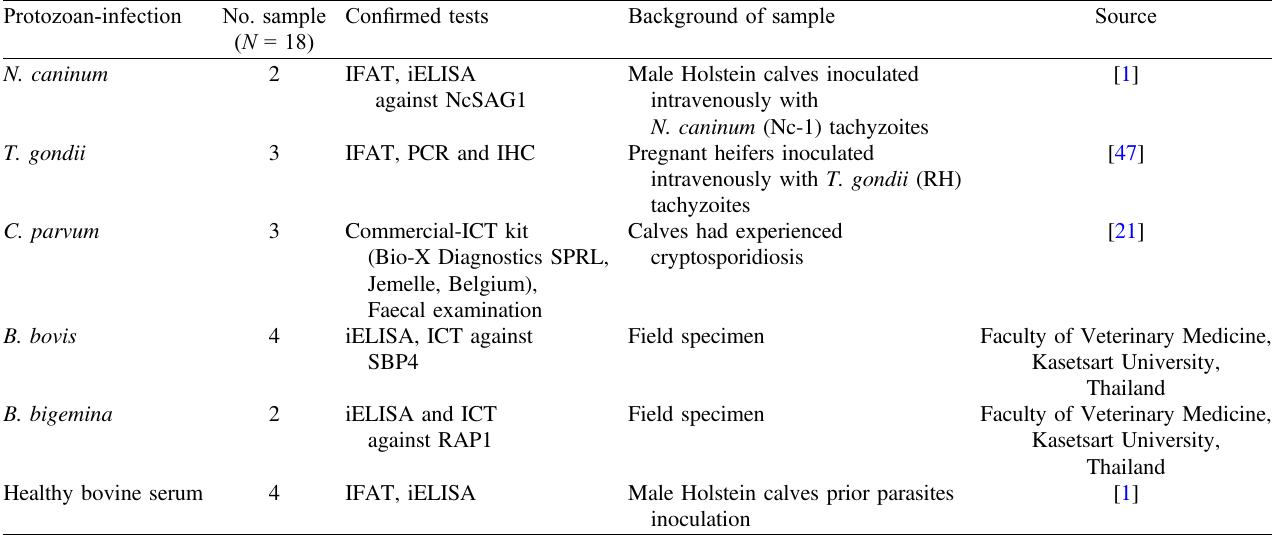
Table 1. List of known bovine serum samples used this study. Protozoan-infection No.